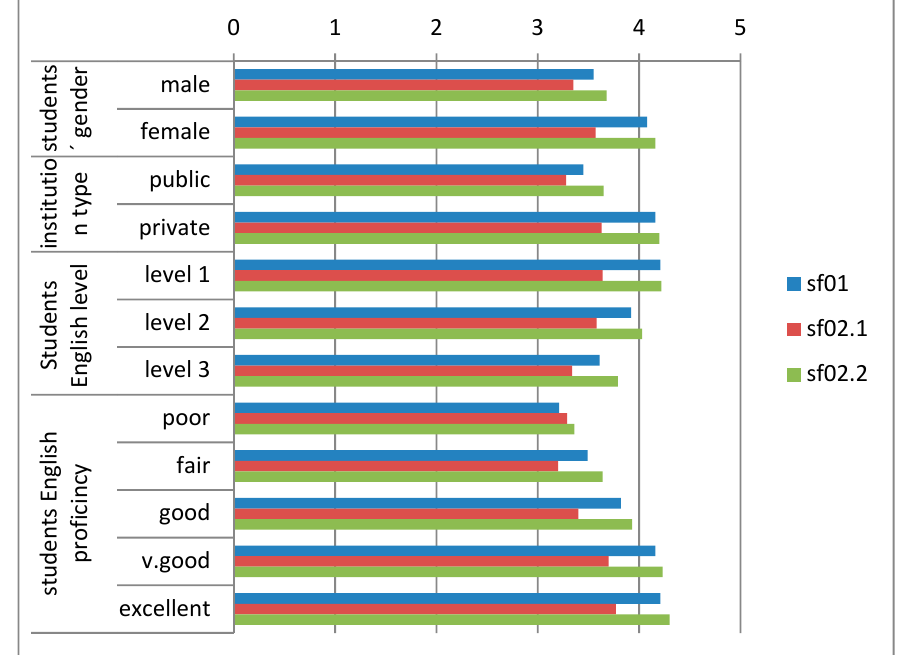
Figure 1. students background and CLT practice in